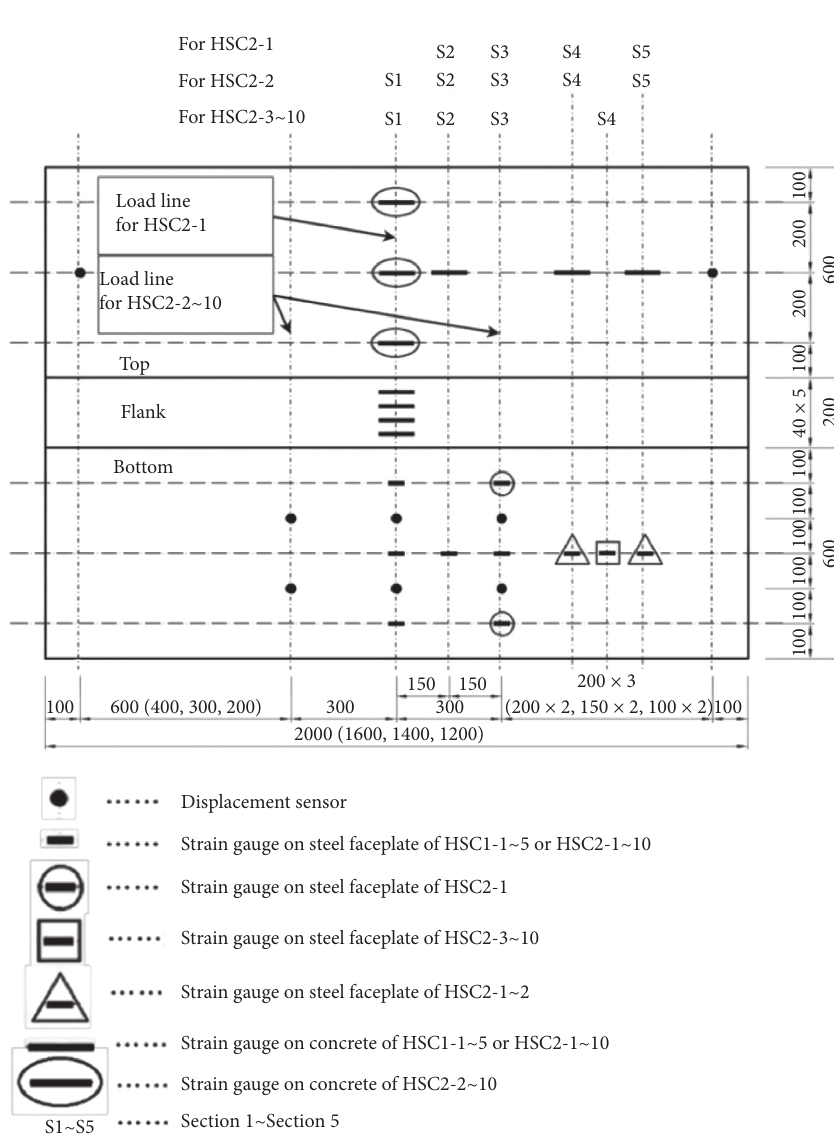
Figure 6: Measuring scheme(unit: mm). (a) Group I. (b) Group II.